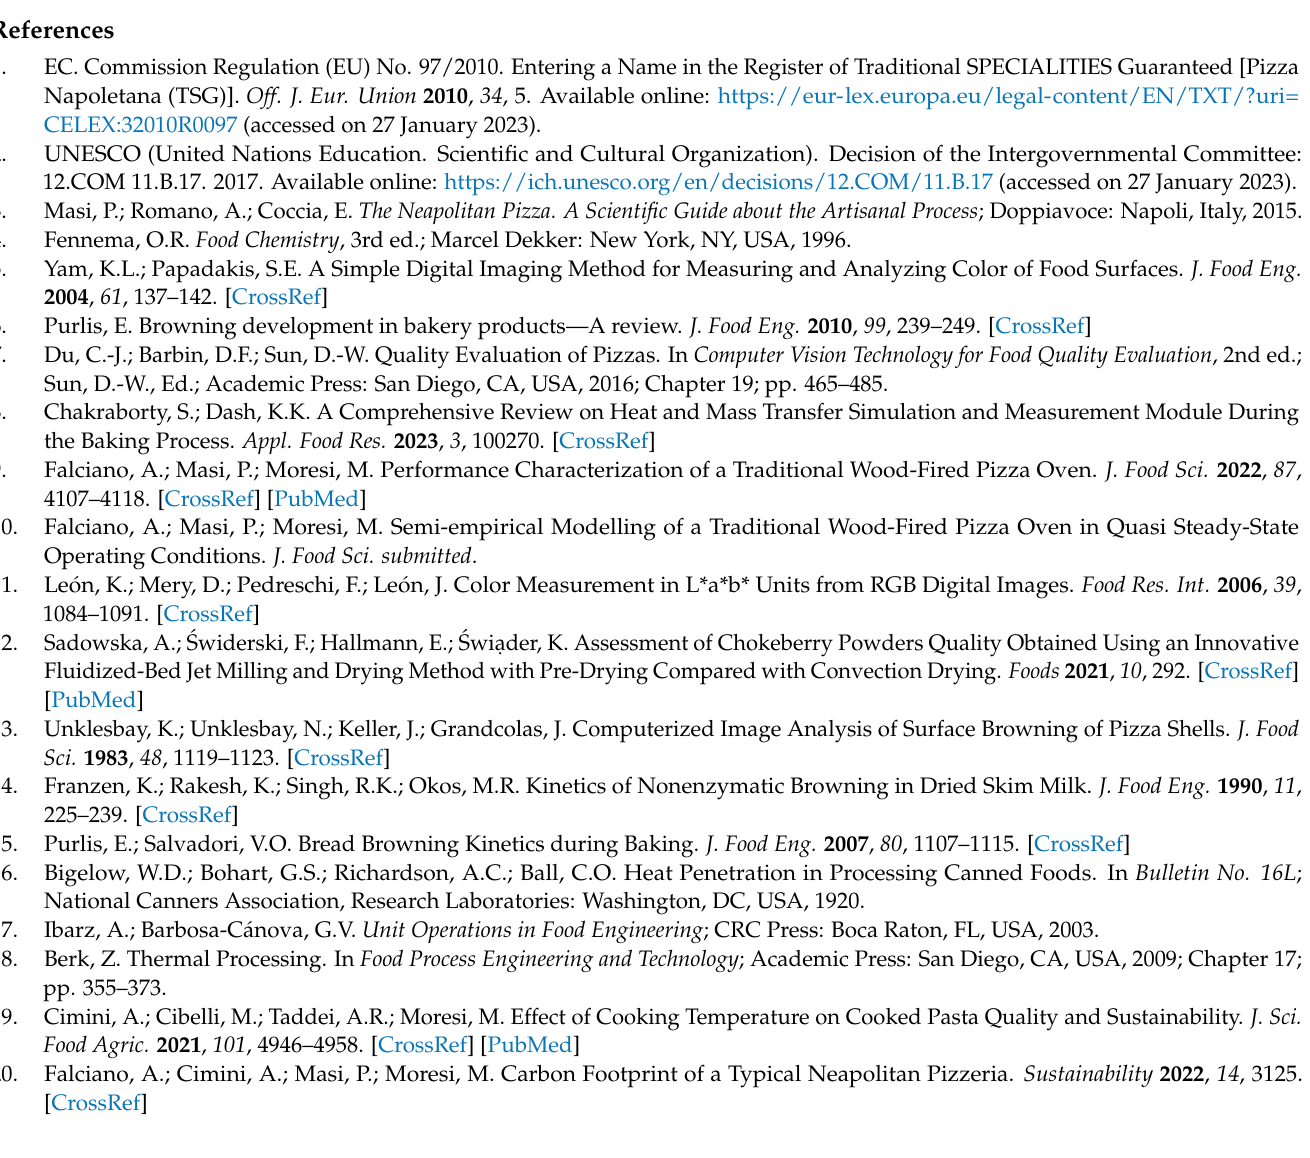
Table S4: Time course of the percentage degree of browned and blackened areas of the upper and lower area of different pizza samples A–E during baking in a wood-fired